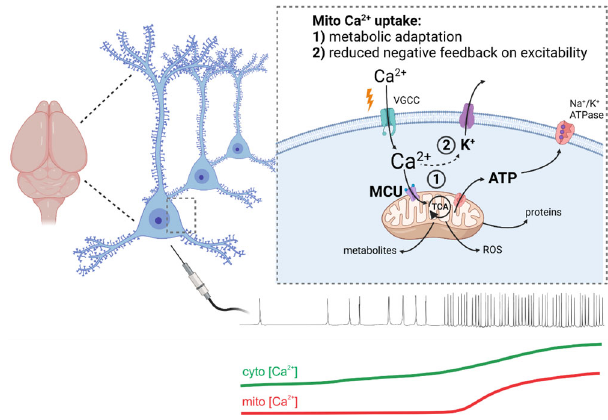
Fig. 8 A functional model for mitochondrial Ca 2 + uptake during shifts to high-frequency action potential fi ring in pyramidal neurons. As pyramidal neurons enter states of high-frequency action potential fi ring, cytosolic Ca 2 + fi rst rises as a result of voltage-gated Ca 2 + in fl ux and subsequently achieves the threshold Ca 2 + concentration required to trigger MCU activation. (1) Mitochondrial Ca 2 + uptake facilitates electron transport chain activity and induces a protracted activation of the TCA cycle leading to increased production of ATP. (2) Simultaneously, the removal of cytosolic Ca 2 + by the mitochondria reduces the coupling between Ca 2 + in fl ux and the activation of the I AHP , which mediates negative feedback control of neuronal excitability. Thus, MCU-dependent mitochondrial Ca 2 + uptake adapts energy metabolism and excitability in a manner that is expected to sustain activity during periods of accelerated action potential fi ring rate underlying information processing by the brain. Illustration was adapted from templates provided by BioRender